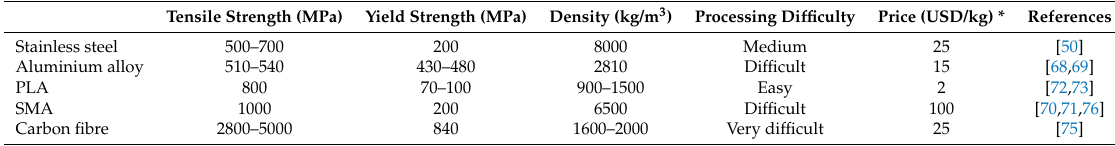
Table 1. Properties of materials used in the production of bionic